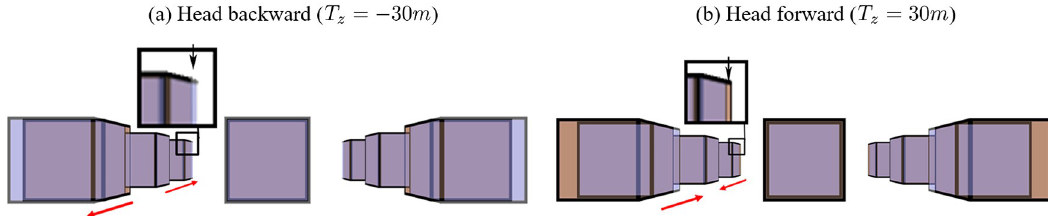
Fig 13. Effects of head translations along the depth ( z -axis) from the cyclopean eye (i.e., only monocular depth cues). (a) Backward ( T = − 30 cm ) and (d) forwards ( T = 30 cm ). The brown cubes are the simulations in the original world and the blue cubes z z are the simulations in the reconstructed world. The red arrows show the cubes become closer and farther, representing compression or expansion in S3D